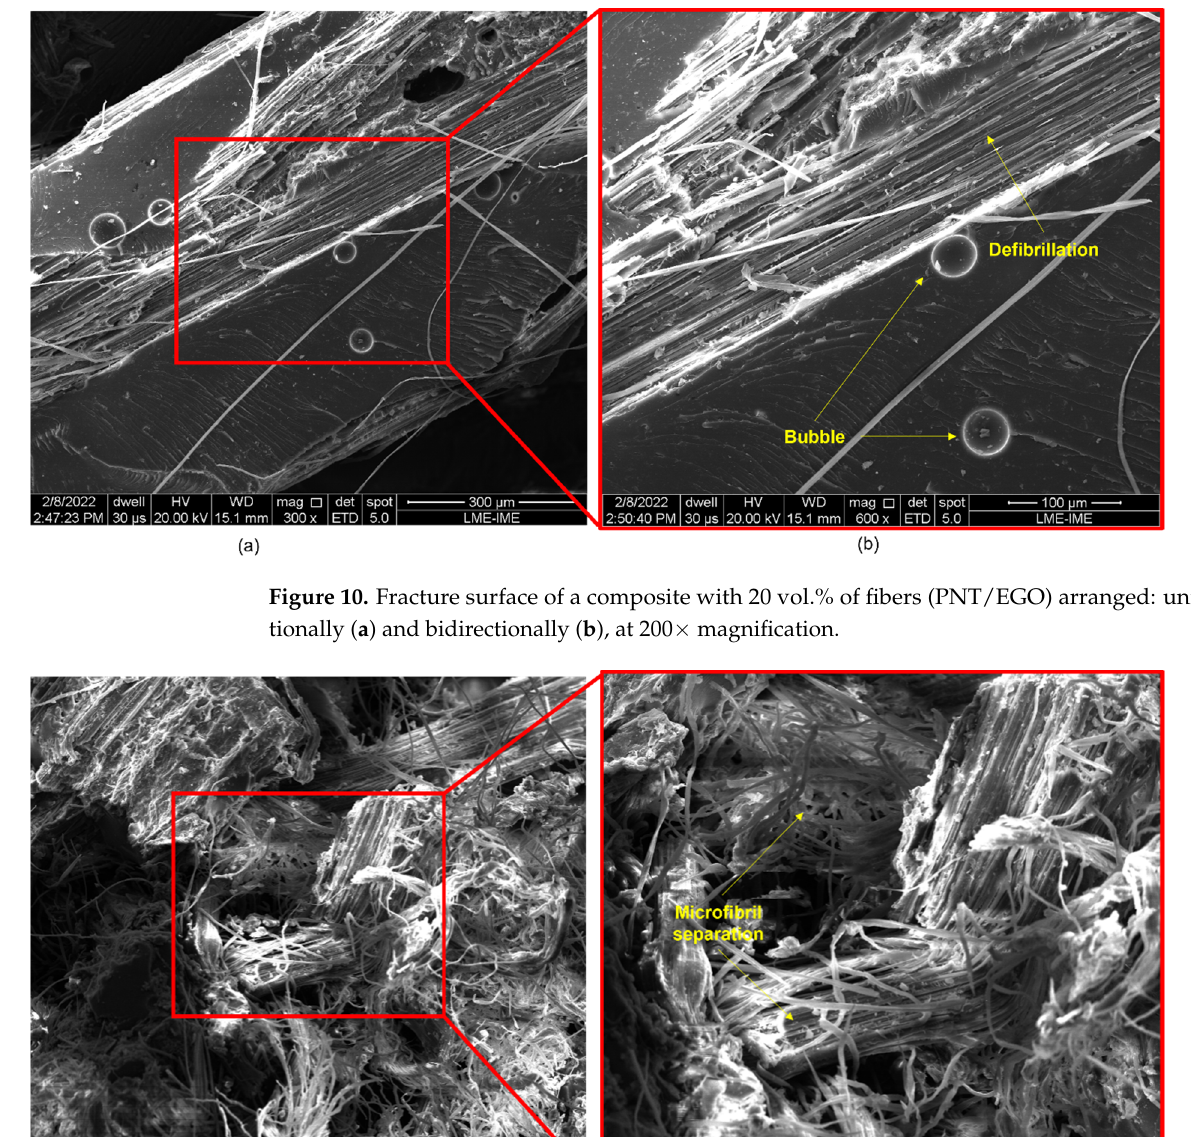
Figure 9. Fracture surface of a bidirectional composite with 30 vol.% fibers (PNT/EGO) at 300× mag- nification.